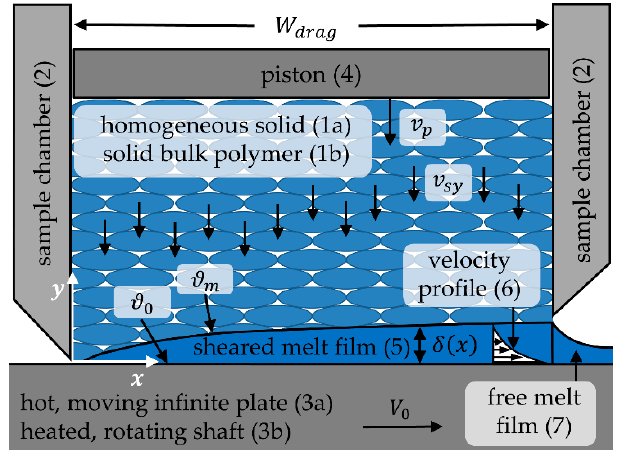
Figure 2. Schematic drawing of the principle of the melting experiment used ( W drag = width of the solid bed, v p = piston velocity, v sy = moving velocity of the solid, ϑ 0 = temperature of the moving plate, ϑ m = melting temperature, V 0 = moving velocity of the plate, δ = melt film thickness, x , y = coordinate directions);